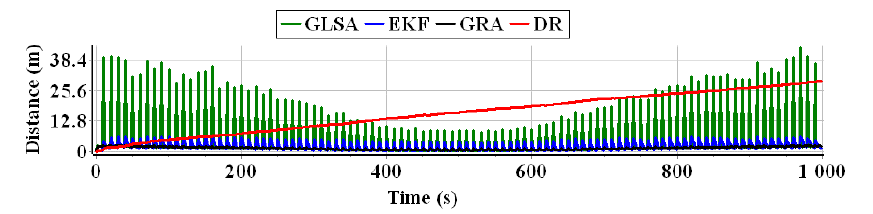
Figure 17. Arithmetic mean distance to the reference position from the estimated position during 100 SV crossings as a function of time.